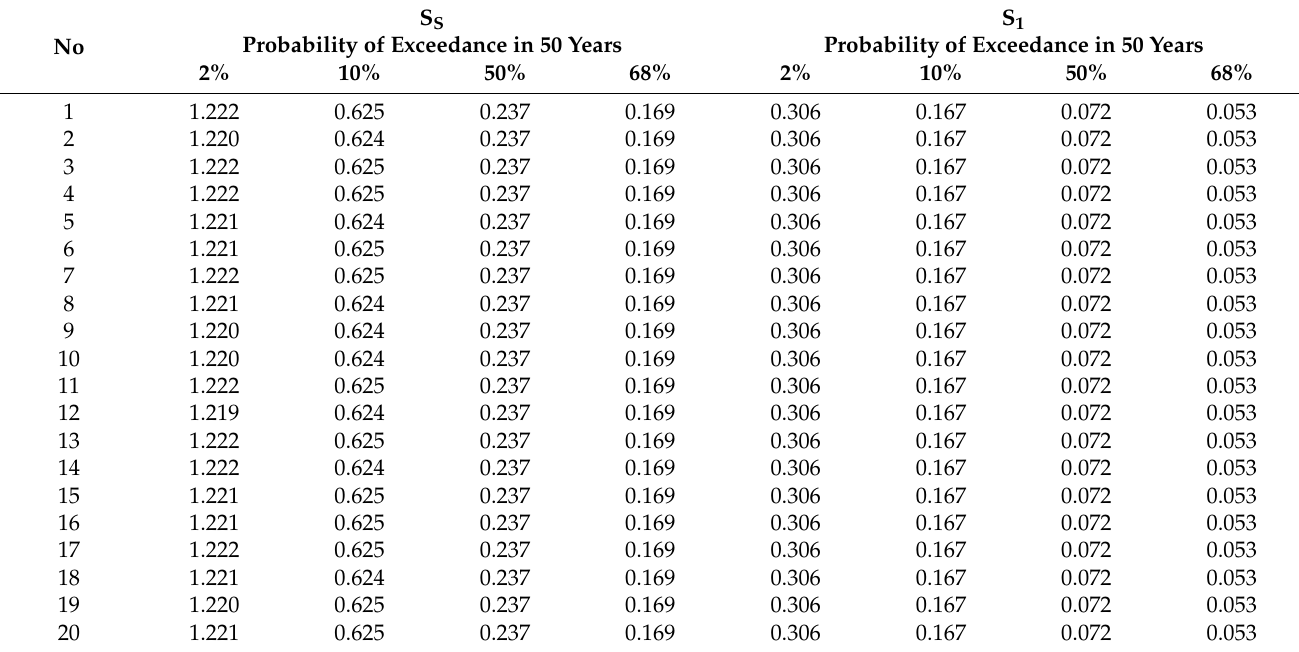
Table 3. S S and S 1 values were obtained for the different probabilities of exceedance.